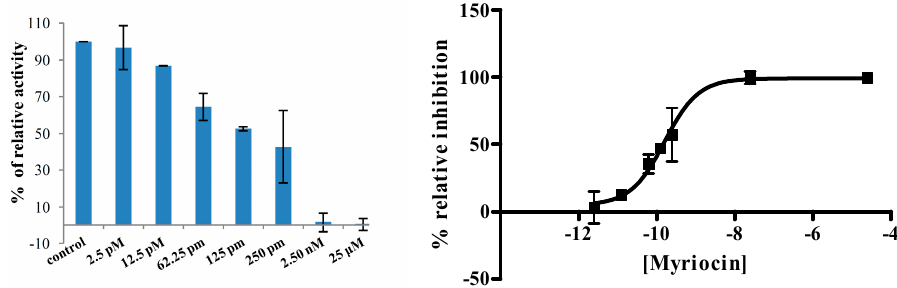
Figure 6. Dose-dependent inhibition of human SPT by myriocin (HPLC-FL assay).